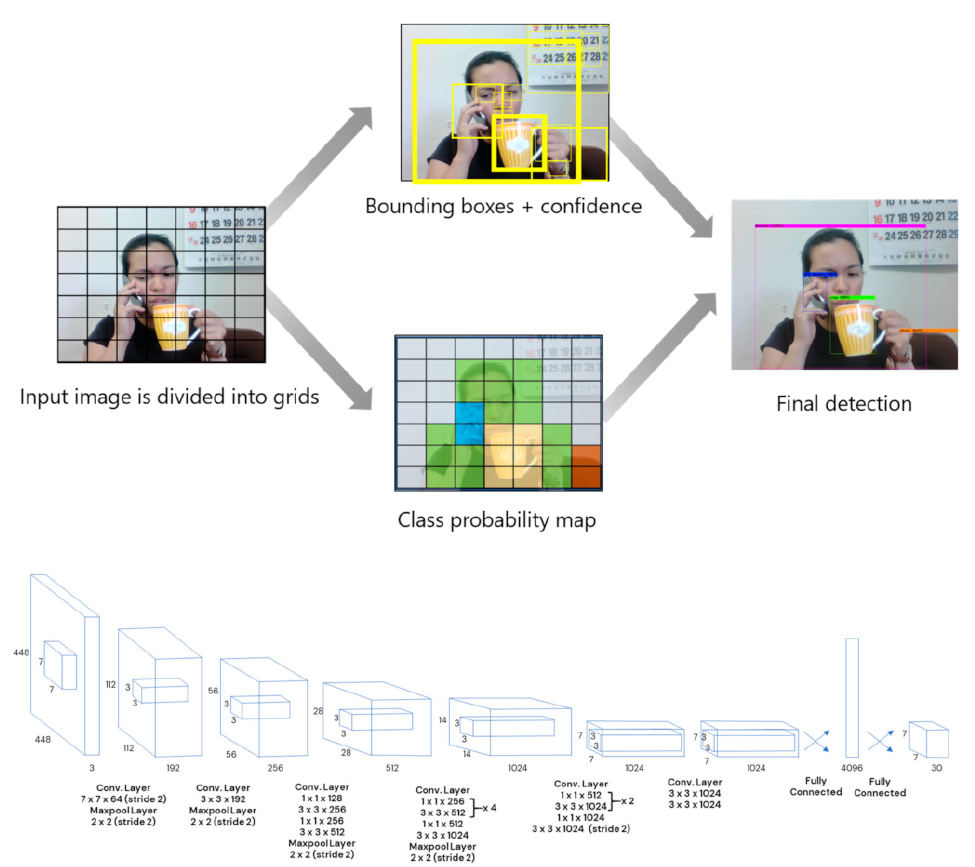
Figure 1. ( Top ) General workflow of YOLO (You Only Look Once); ( Bottom ) YOLO Architecture. However, the YOLO had its downsides. It had difficulties in detecting small objects and objects with unusual aspect ratios. It also made more localization errors compared to the state-of-the-art object detection model, Fast R-CNN. In 2017, a more accurate counter- part of YOLO was introduced, which was called YOLOv2. The accuracy improvements in YOLOv2 were mainly due to the use of anchor boxes in predicting the location of objects in an image, batch normalization in the convolutional layers, and high-resolution classifier. Because of these improvements, YOLOv2 was able to outperform some state-of-the-art models such as Faster R-CNN with a mAP of 78.6% and an inference speed of 40FPS on a Pascal VOC 2007 dataset and an mAP0.5:0.95 of 21.6% on an MS COCO test-dev 2015 [19]. Then, a year after, several improvements were applied to YOLOv3. In this version, the previous backbone network of YOLOv2 (Darknet-19) was replaced with Darknet-53.